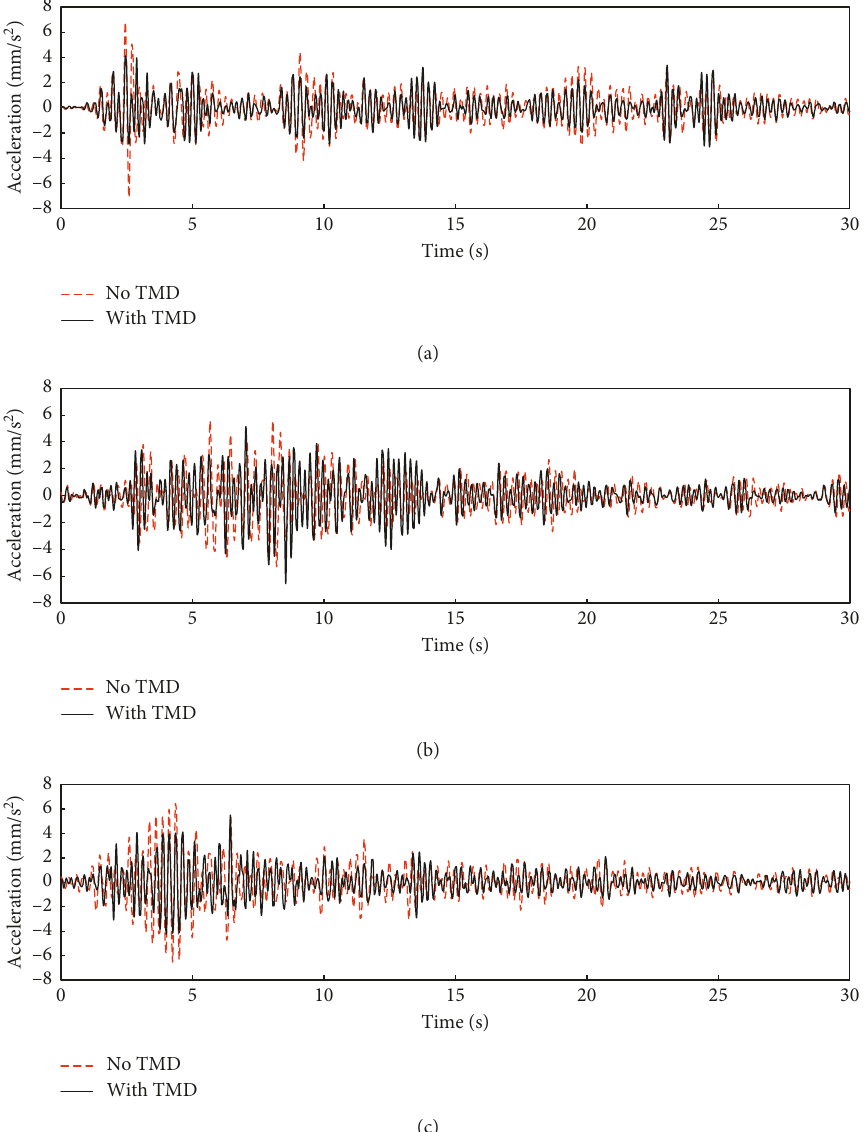
Figure 13: Acceleration responses of the platform subjected to the three earthquake-induced seismic waves by experiment. Acceleration time series under the (a) El-Centro NS seismic wave, (b) Taft EW seismic wave, and (c) Fukushima NS seismic